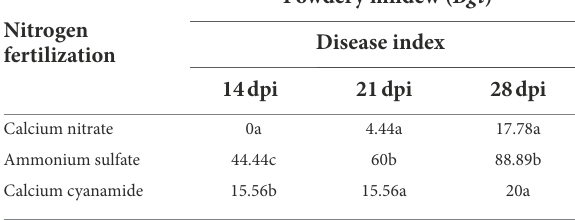
Data represent mean values of three biological replicates ± SE. The different lowercase letters indicate a significant difference at 0.05 probability level according to Tukey multiple comparison